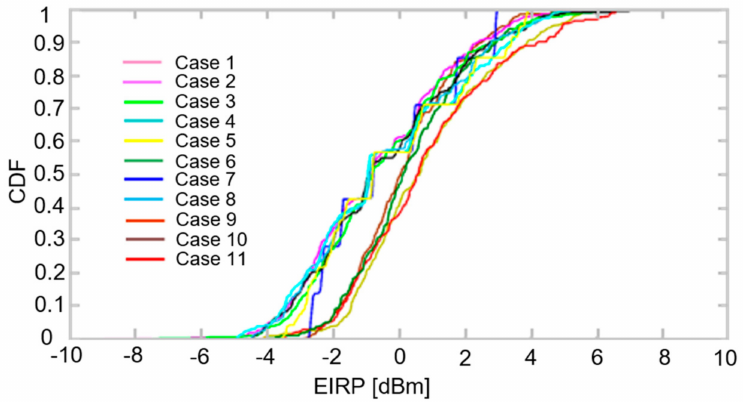
Figure 12. EIRP CDFs comparison within 75 ◦ to 105 ◦